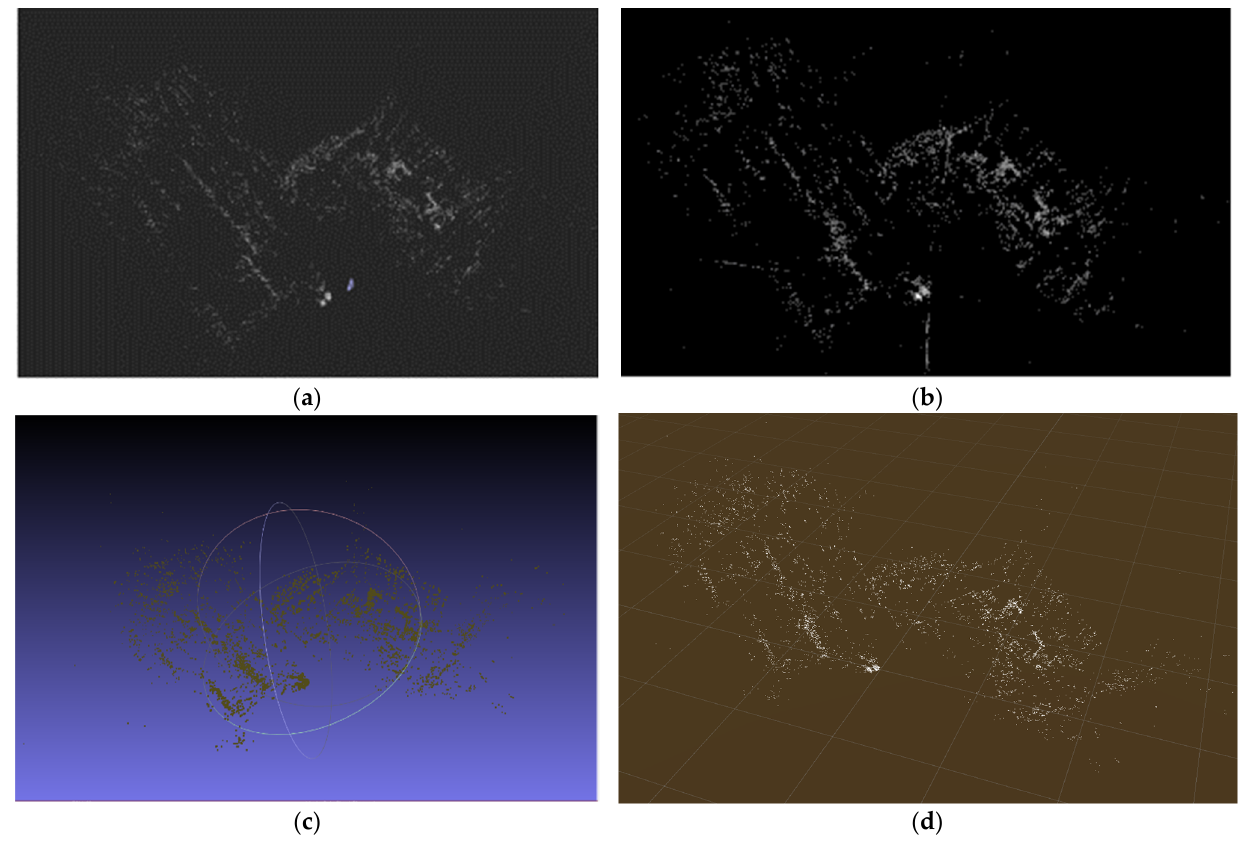
Figure 6. Visualization of SLAM; ( a ) Pangolin Viewer; ( b ) Mobile device; ( c ) 3D Visualization with Meshlab, ( d ) 3D Visualization with RTABMap.